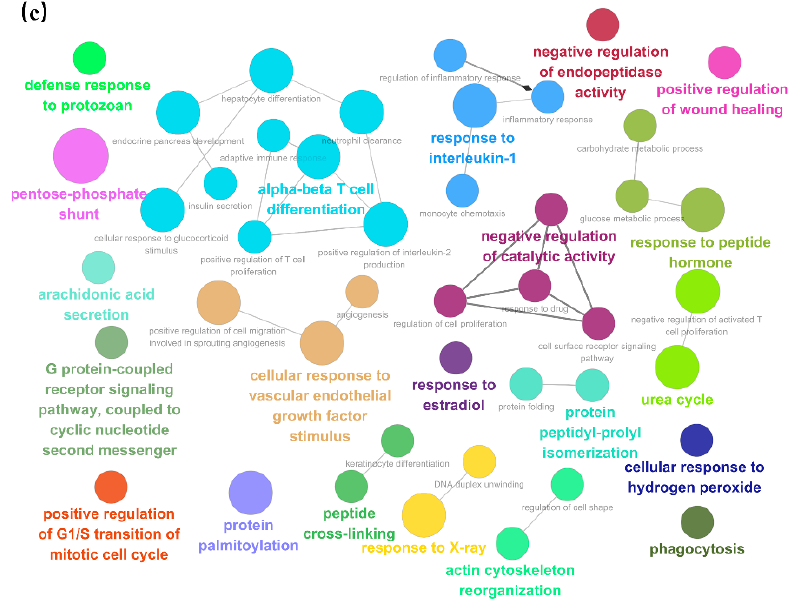
Figure 4. ClueGO network of GO terms. ( a–c ) represent the GO annotation results from trends 5–7, respectively. Each node represents a term, and different node colors represent various categories to which they belong.